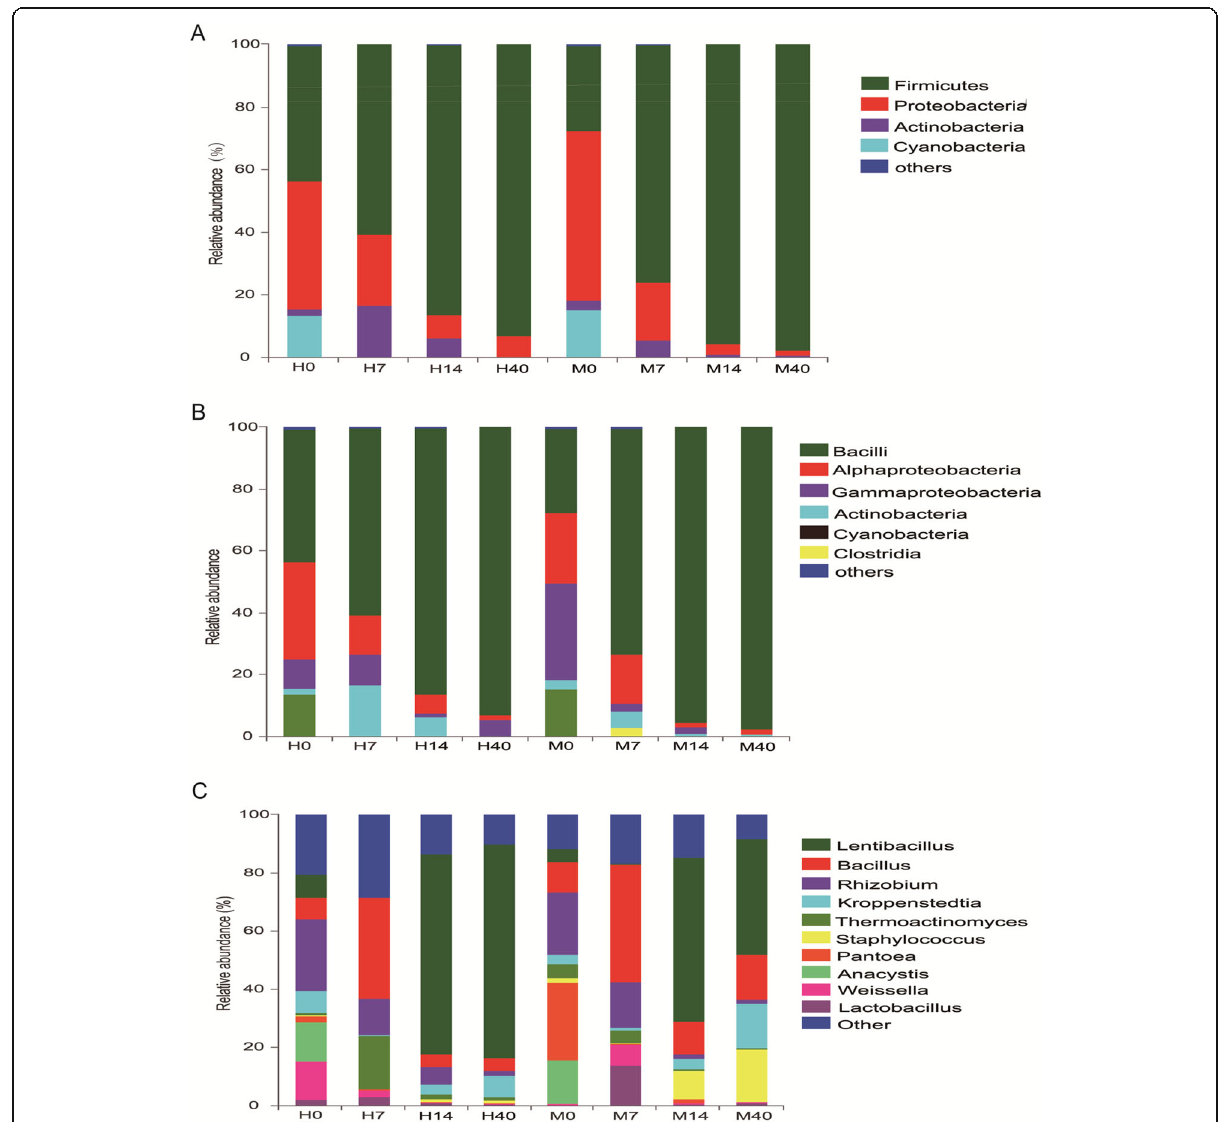
Fig. 3 Relative abundance of bacterial community compositions at phylum ( a ), classes ( b ), or genus ( c ) levels in Daqu H and Daqu M samples during